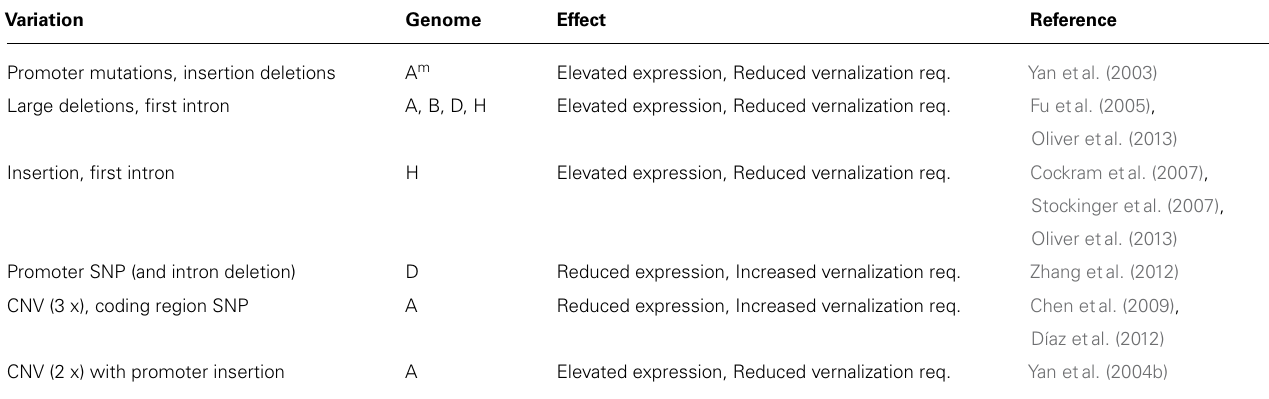
Table 1 |Variation in the VRN1 gene of cultivated